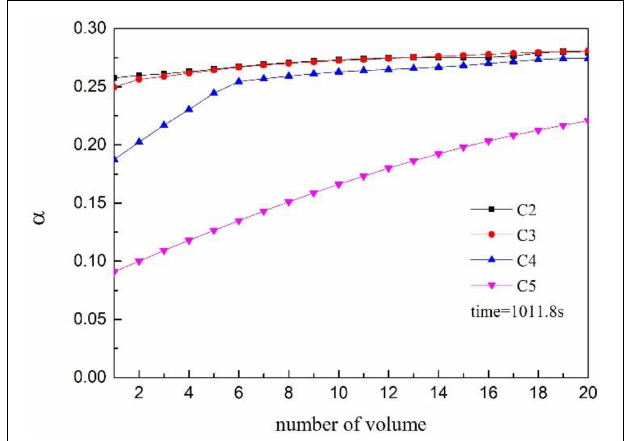
FIGURE 6 | The void fraction of different volume in vessel.